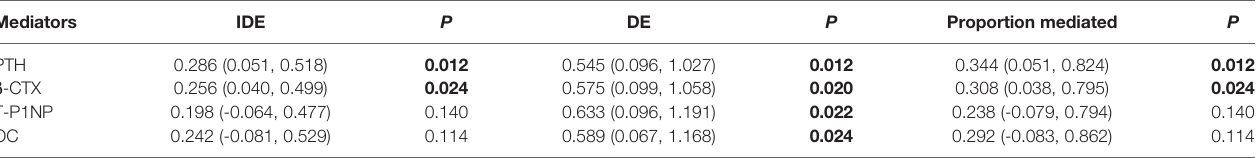
TABLE 4 | Mediators of the association between CKD stages and PI.